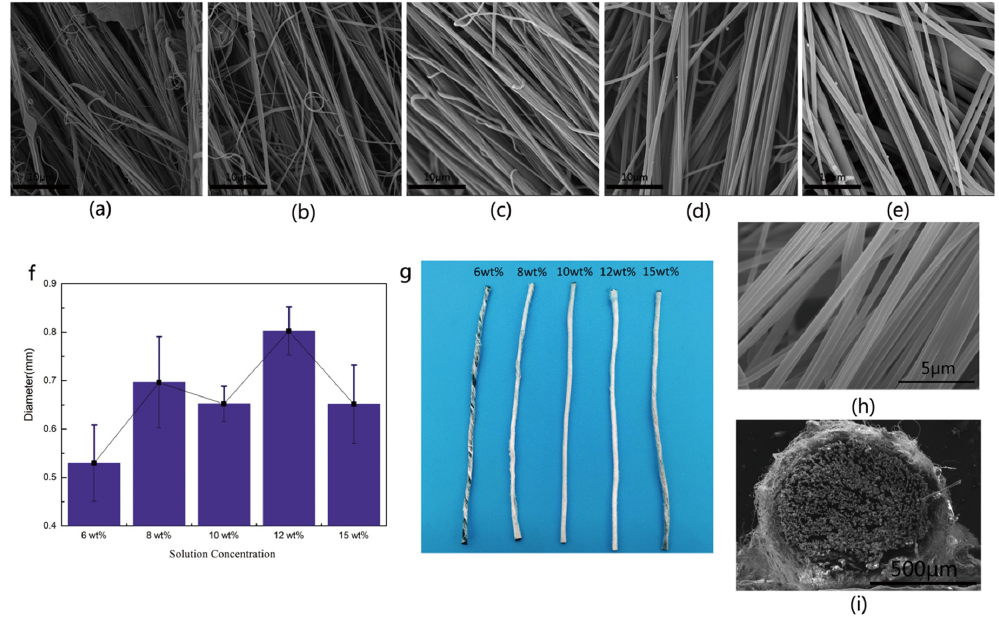
Figure 3. Surface morphology of ( a ) CFs@6 wt% ‐ PAN NFs, ( b ) CFs@8 wt% ‐ PAN NFs, ( c ) CFs@10 wt% ‐ PAN NFs, ( d ) CFs@12 wt% ‐ PAN NFs and ( e ) CFs@15 wt% ‐ PAN NF, ( f ) diameter distribution and variance diagram of nanofiber yarn with different concentrations, ( g ) photo of the yarn, ( h ) morphology of nanofibers, ( i ) cross sectional morphology of CFs@10 wt% ‐ PAN NFs.